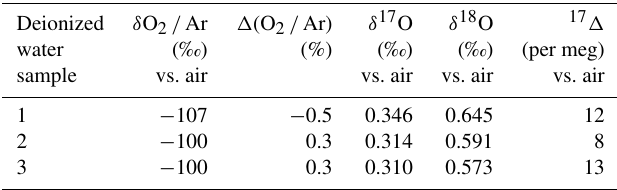
Table 1. Air–equilibrated water